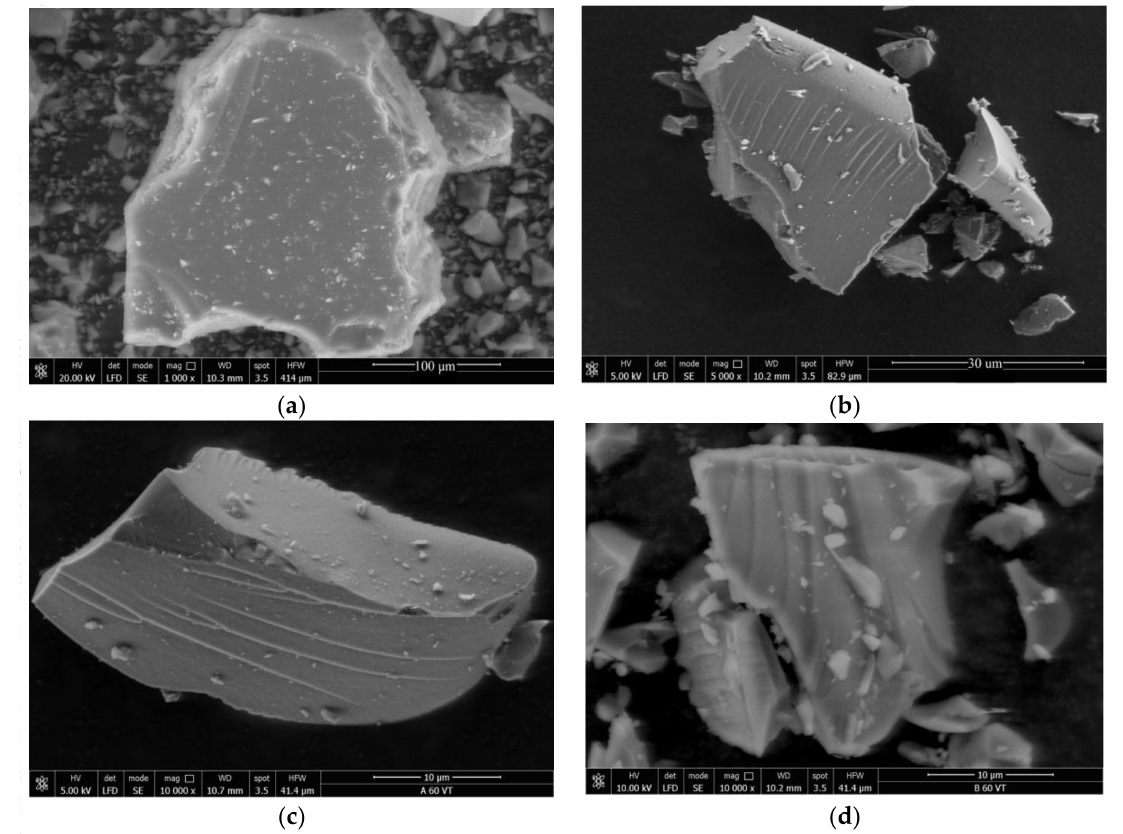
Figure 7. Evolution of the morphology of the hybrid silica gels distinguished by SEM images for samples from A and B series (( a ) B05-VTAS; ( b ) B20-VTAS; ( c ) A60-VTAS; ( d )